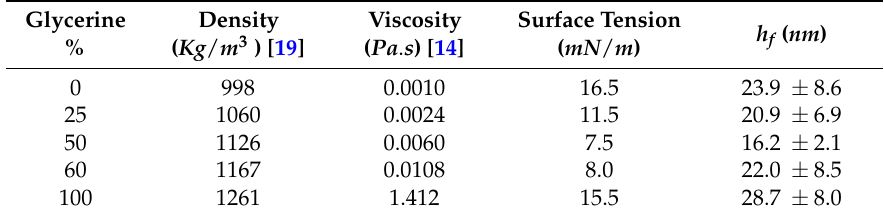
Table 1. Experimentally measured PEO thickness and surface tension of PS-PEO covered toluene drops for a range of glycerine/water solutions.